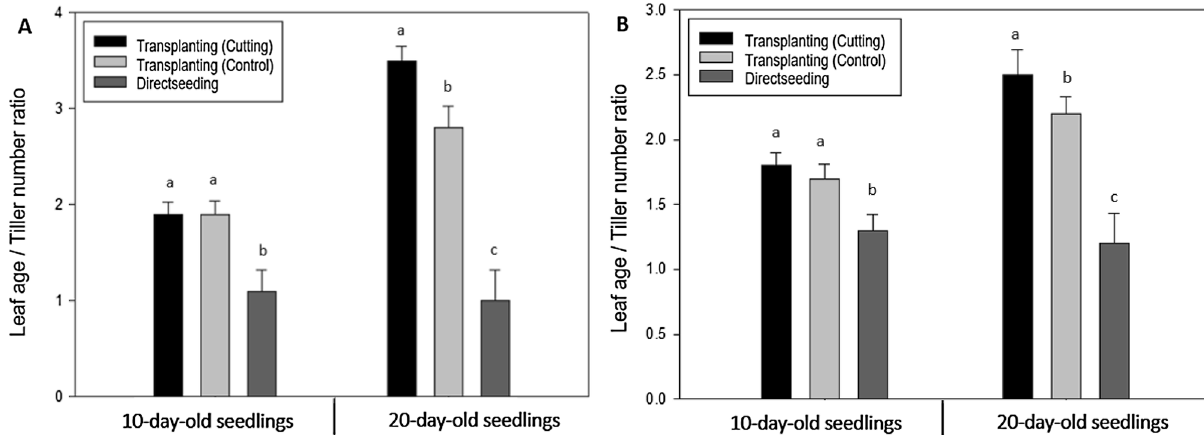
Figure 6. The difference in the ratio of the final number of leaves and tillers in response to root cutting conditions and seedling age in rice. ( A ) Odae, ( B ) Saenuri. Significant differences were evaluated using Duncan’s multiple range test at the 5% level. Error bars are standard